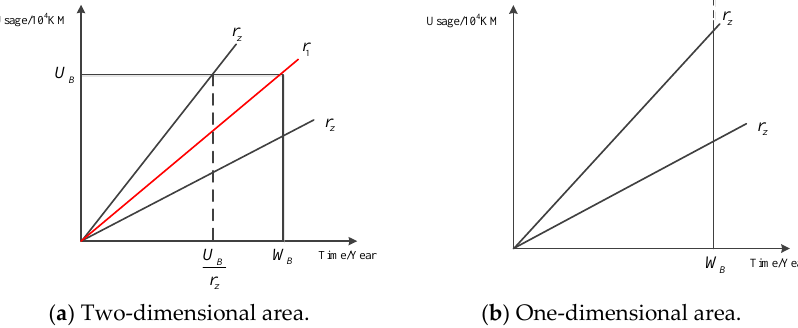
Figure 18. Warranty area under different warranty methods.